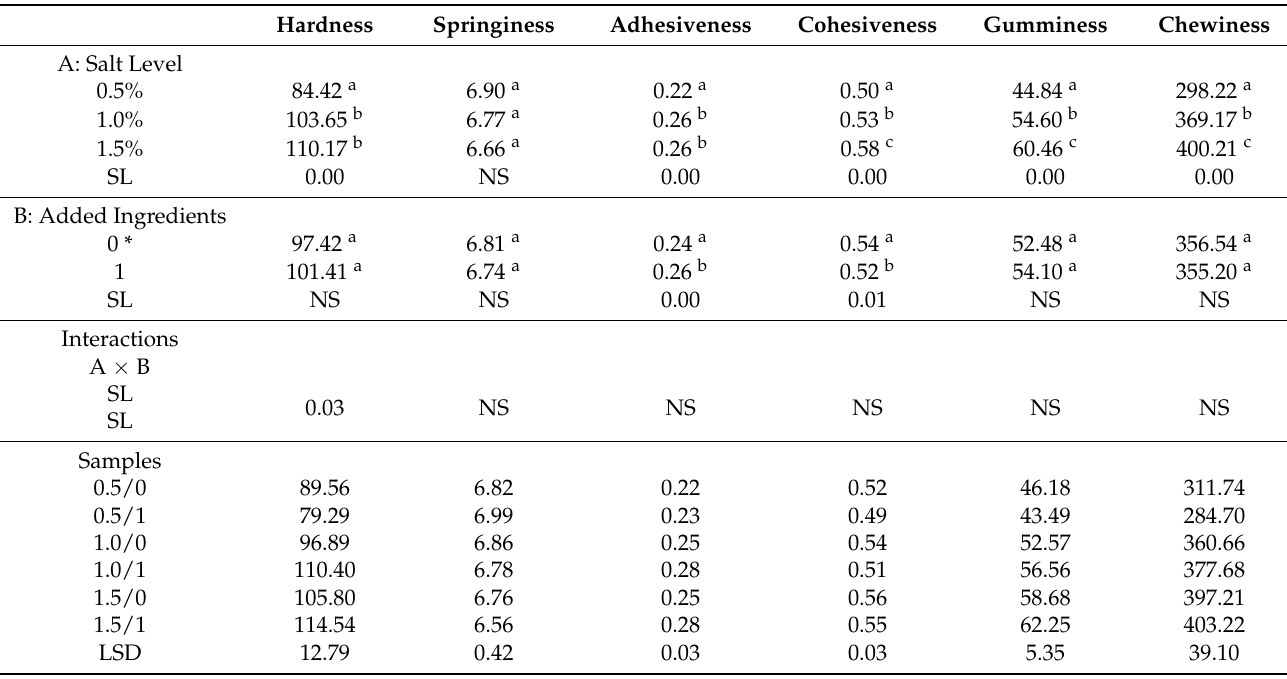
Table 5. The effect of salt levels and added ingredients KCl \ TS on the textural properties of breakfast sausages manufactured with pork belly meat high pressure treated at 150